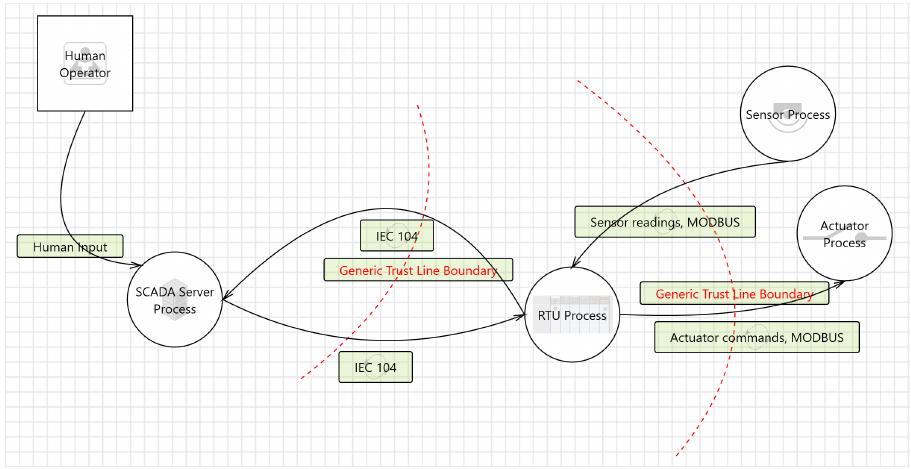
Figure 2. Process-oriented SG-TMT model focusing on cyber threats requiring physical